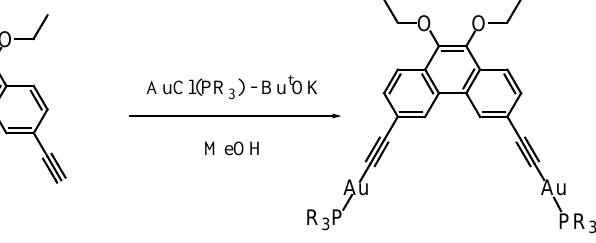
Scheme 1. Synthesis of 3,6-diethynyl-9,10-diethoxyphenanthrene ( 4 ).